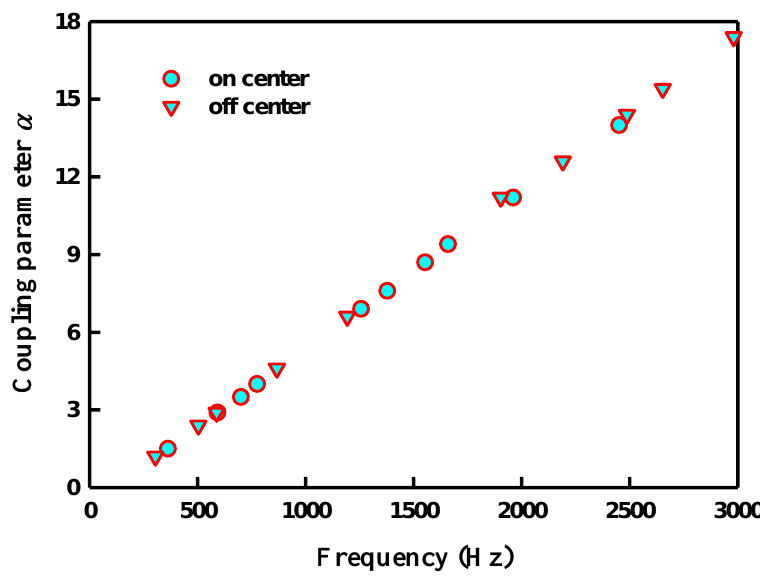
Figure 7. Dependence of the coupling strength on the resonant frequency by means of the best reconstruction of experimental patterns.